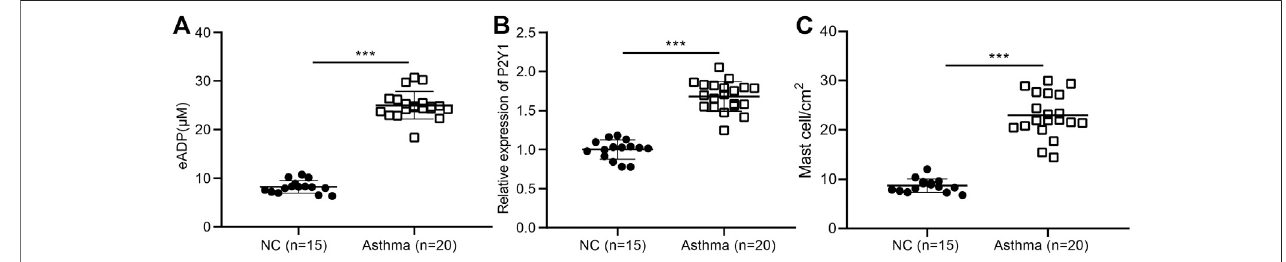
FIGURE2| HighconcentrationsofextracellularADP intheBALF ofasthmatic patients. (A) ADP releasein BALF ofasthmapatients ( n (cid:2) 20) and healthy volunteers ( n (cid:2) 15). *** p < 0.001 compared with the healthy volunteers. (B) P2Y1 receptor expression in lung tissuesofasthma patients ( n (cid:2) 20) and healthy volunteers determined byRT-qPCR( n (cid:2) 15). (C) Toluidineblue stainingofthe in fi ltration ofMCsinthe lungtissue ofasthma patients.*** p < 0.001compared withthehealthyvolunteersorPBS treatment. Measurement data were expressed by the mean ± standard deviation, analyzed by independent sample t test, and the experiment was repeated three times.